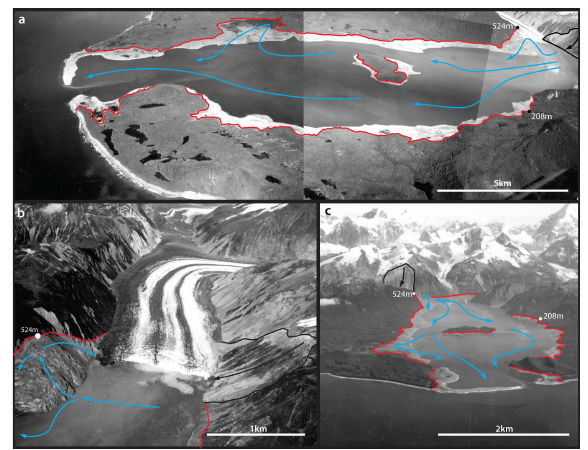
Fig. 10. Lituya Bay following the 1958 tsunami. (a) NW panoramic view of Lituya Bay and Centoaph Island; (b) NW view of Gilbert Inlet and Lituya Glacier showing landslide scar and wave run-up on spur opposite landslide; (c) NE view of Lituya Bay. Photos from